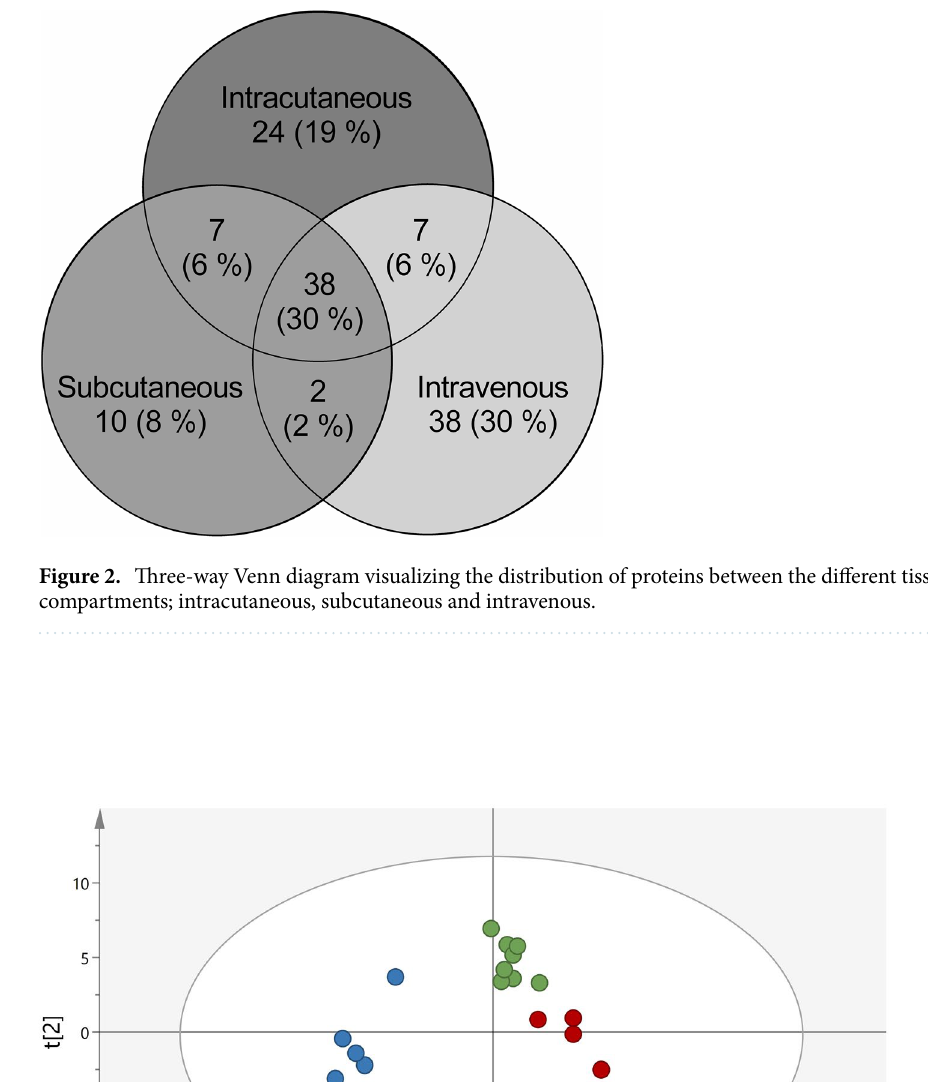
Table 2. Significant proteins (VIP > 1) in the orthogonal partial least square discriminant analysis (OPLS-DA) model of all three compartments (intracutaneous, subcutaneous and intravenous) that contributed most to the separation in protein expression before (baseline) and after glucose provocation (Fig. 4). ↑ = Upregulated; ↓ = Downregulated after glucose provocation compared to before (baseline). Proteins were considered